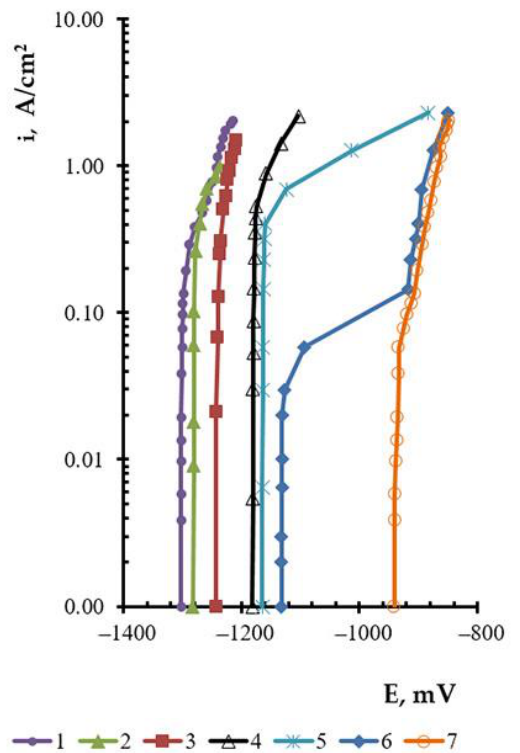
Figure 1. Experimentally obtained anode polarization of individual 3 Pb, Bi and double alloys at 823 K, mol.%: 1—Pb; 2—Pb–Bi (59.3–40.7); 3—Pb–Bi (32.5–67.5); 4—Pb–Bi (7.0–93.0); 5—Pb–Bi (5.0–95.0); 6—Pb–Bi (3.0–97.0); 7—Bi.